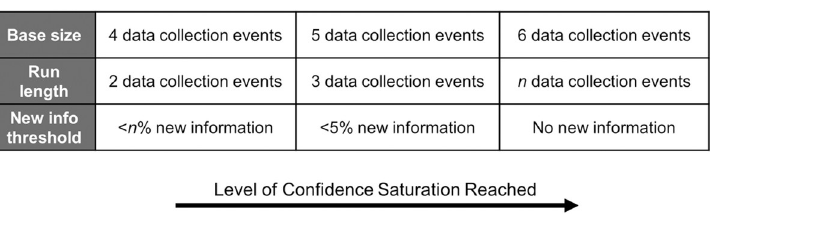
Fig 2. Saturation assessment parameters and level of confidence saturation